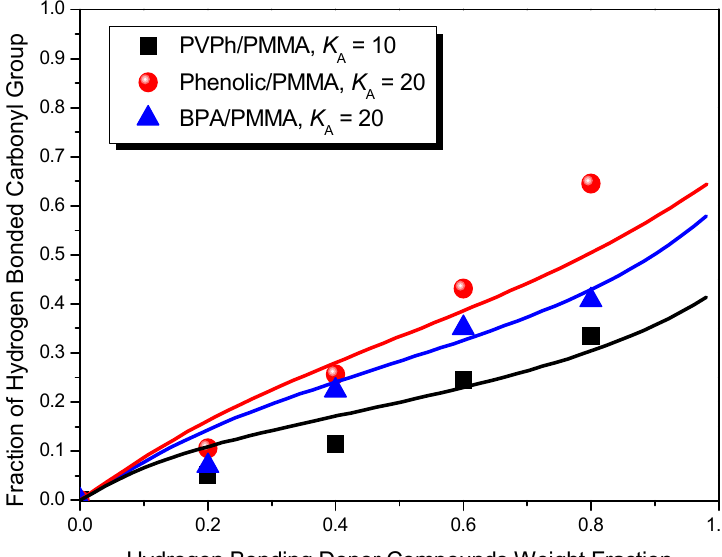
Figure 10. Fraction of hydrogen-bonded C=O groups of PMMA in the presence of different hydrogen bonding donor compounds, determined from FTIR spectra, and values of K calculated using the Painter–Coleman association A